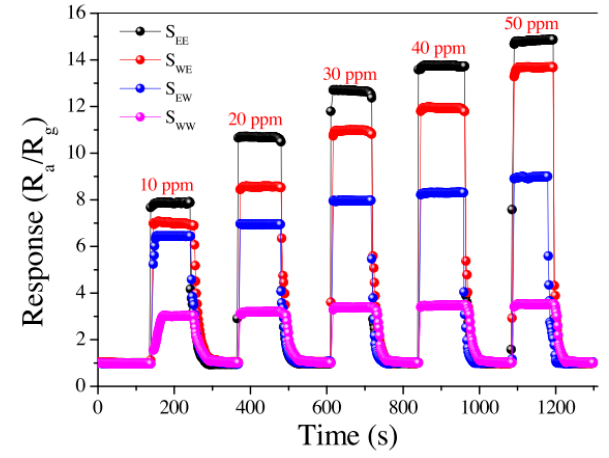
Figure 12. Responses to 10, 20, 30, 40 and 50 ppm of ethanol gas of imprinted and nonimprinted sensors at 300 °C [53].